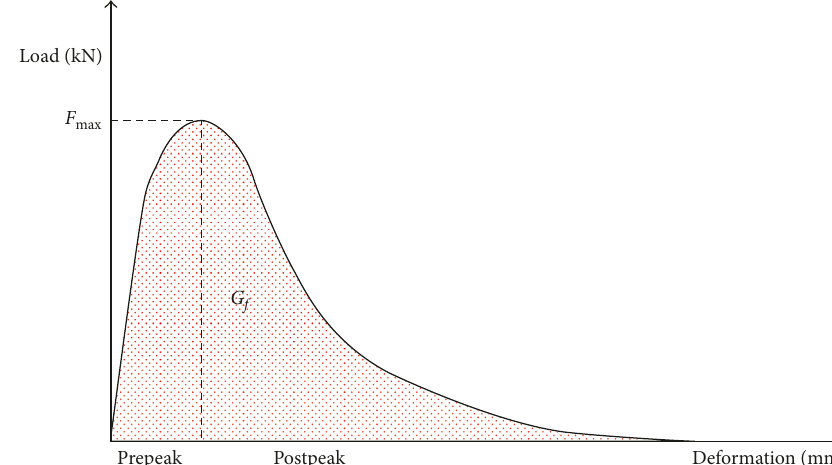
Figure 5: Principle of calculation of fracture energy.